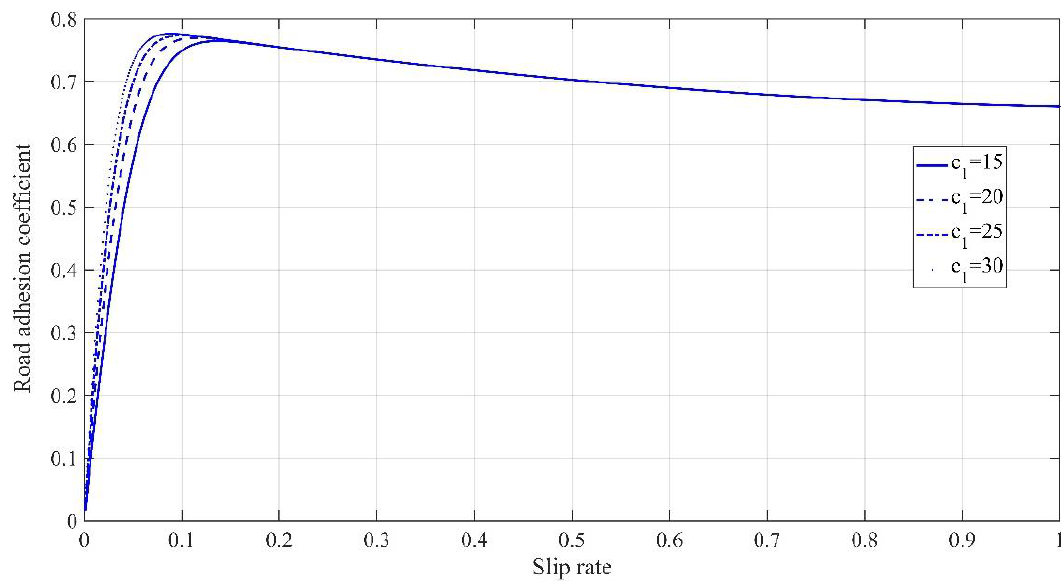
Figure 9. Relationship between the road adhesion coefficient curve and 𝑐 1 .